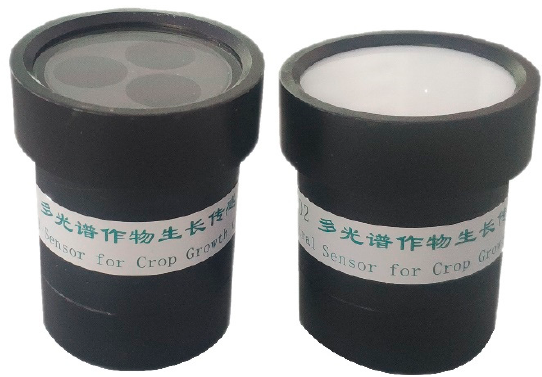
Figure 2. Multispectral sensor.